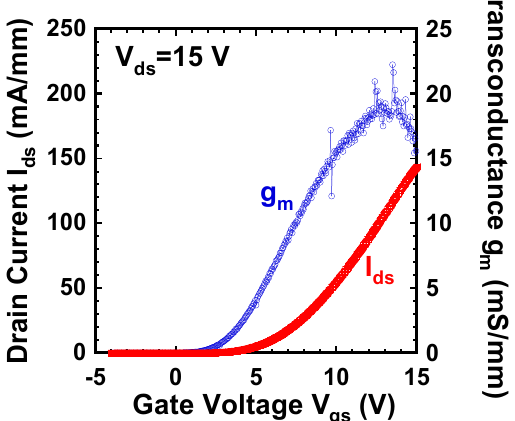
Figure 11. Subthreshold characteristics of the DMOSFET. D it estimated from subthreshold slope of 264 mV/dec was 2.1 × 10 12 cm − 2 ·eV − 1 .